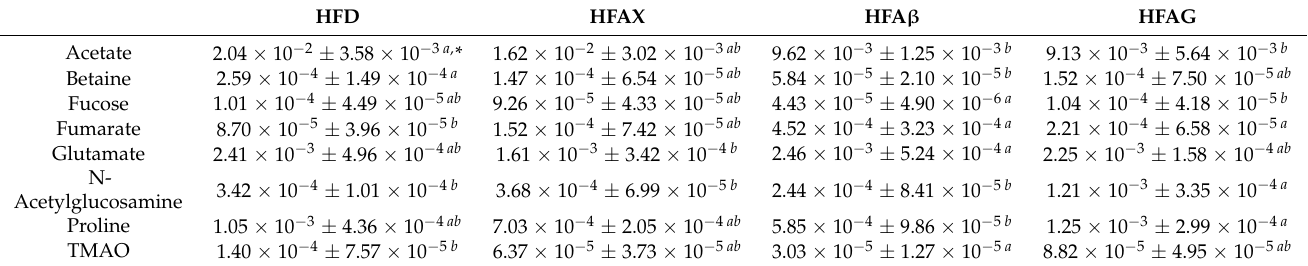
Table 3. Molecules with significant differences in cecum contents of HFD, HFAX, HFA β , and HFAG groups.